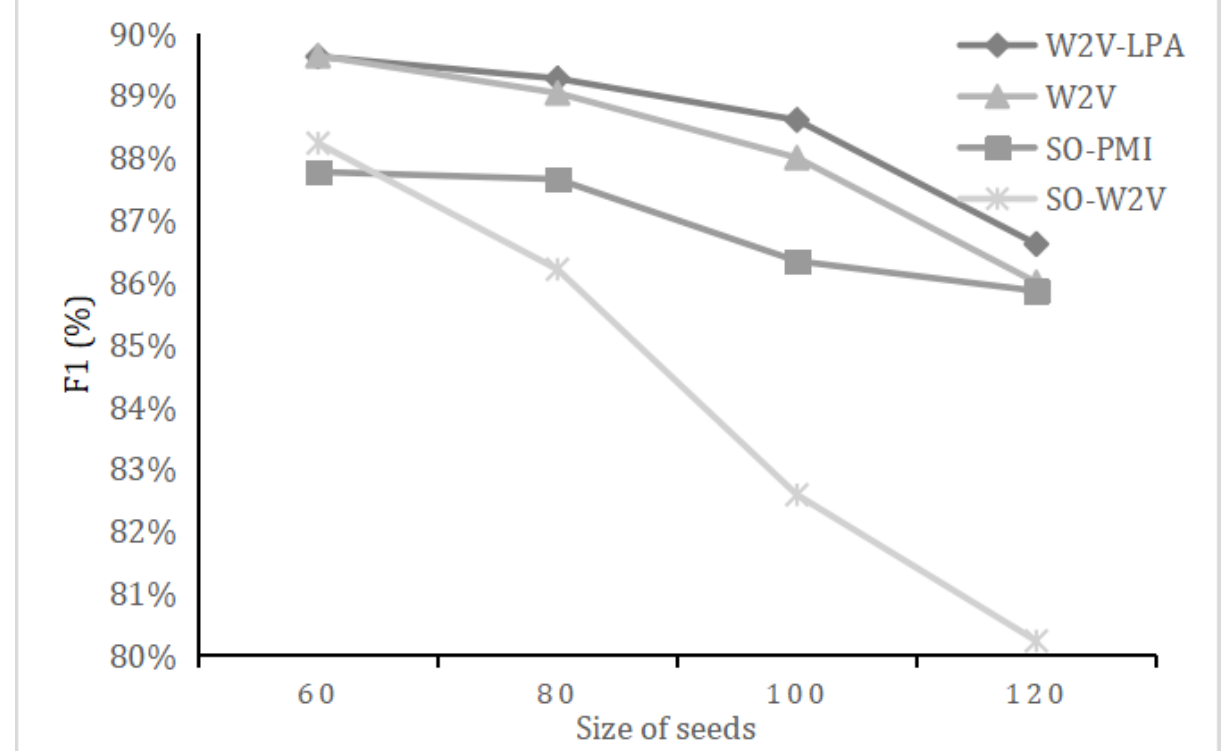
Figure 3. F1 of methods when the seed size changed. LPA: label propagation algorithm; SO-PMI: semantic orientation pointwise mutual